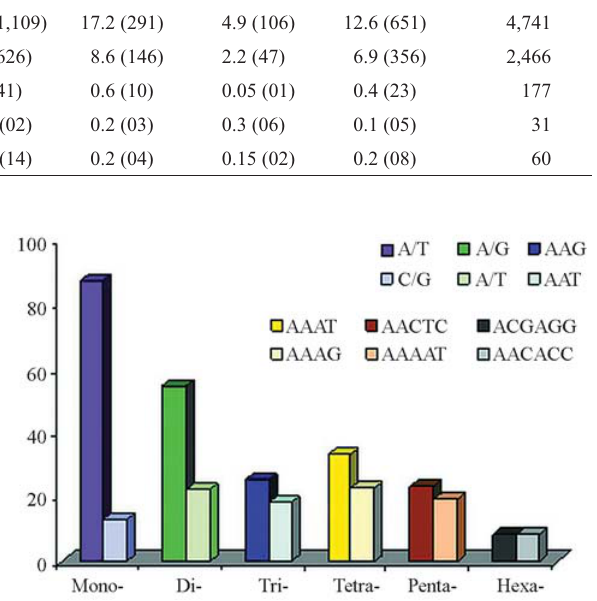
Figure 1 - Frequency of the most common SSR motifs in CitEST data- base.